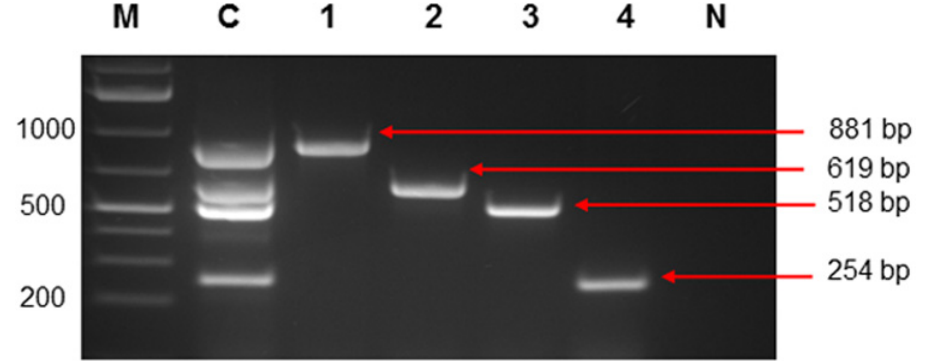
Fig 1. Control strains of E . coli using virulent specific primers. Lane M: Generuler 1 kb plus (Fermentas); lane C: Multiplex of e ae (EPEC), ipaH (EIEC), stx (EHEC), aggR (EAEC); lane 1: eae (881 bp); lane 2: ipaH (619 bp); lane 3: stx (518 bp); lane 4: aggR (254 bp) and lane N: negative control.